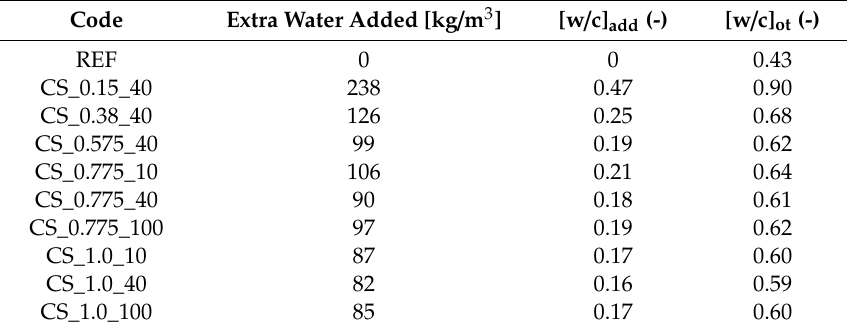
Table 1. Studied mortar mixtures with their code, extra water added and corresponding water-to-cement ratios (additional and total) for Series 1 and